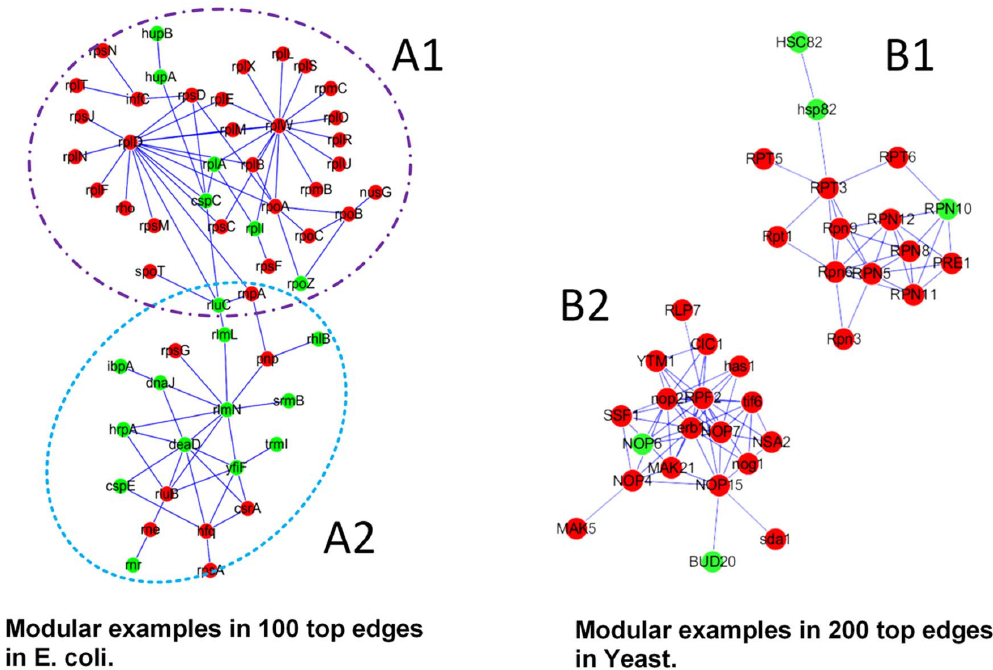
Figure 5. Modular examples in Yeast and E.coli PPI network by top edges. The red nodes are essential proteins and the green ones are non- essential proteins. Figure S1 PR curves of different combination of mea- sures in EW on Yeast PPI networks. 15 PR curves with Figure S2 PR curves of different measures combination in EW without PP vs. with PP on Yeast PPI networks. And PP vs. average performance by 10 times randomly sorted all edges on Yeast PPI networks. From the PR curves in (A)–(G), we can see except when combined with GE. In (H), the performance with PP